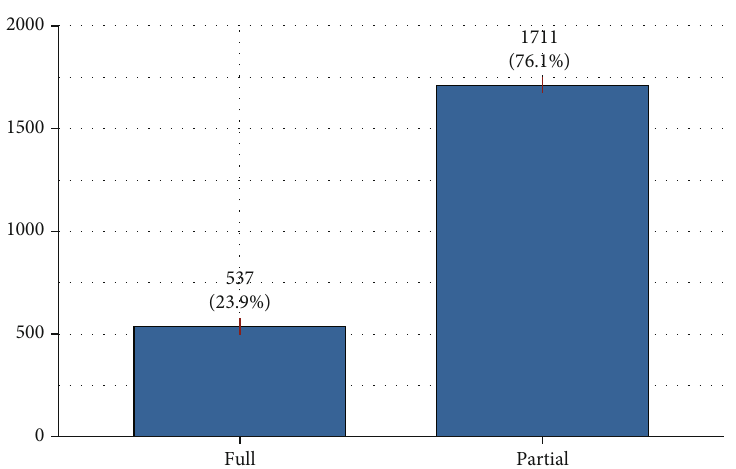
Figure 1: Malaria preventive measures (LLIN and